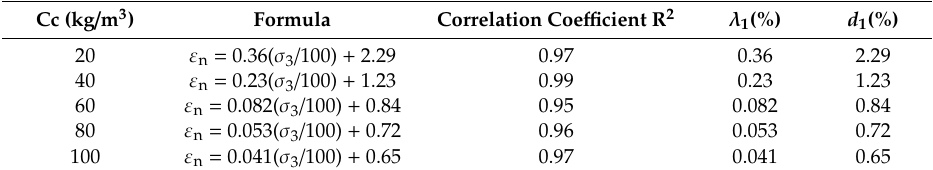
Table 7. Values of R 2 , λ 1 , and d 1 .